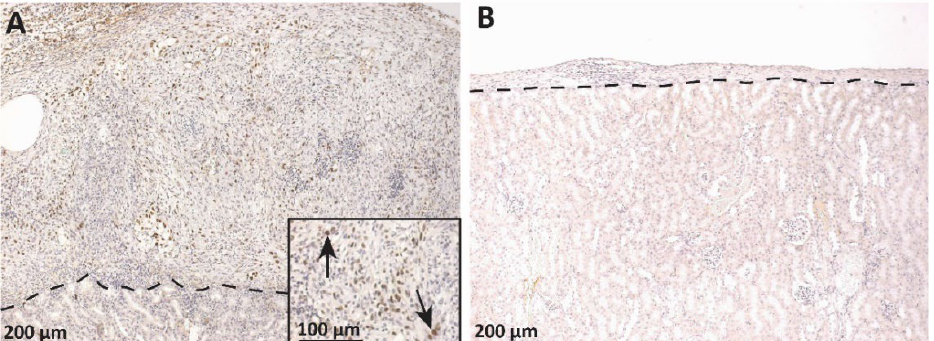
Figure 3. Immunohistochemical analysis of SC or MSC-1 cell allograft survival. Four million SCs or MSC-1 cells were transplanted under the kidney capsule of BALB/c mice. The grafts were collected on day 20 post transplantation and immunostained for SCs (WT1, brown ( A ) or MSC-1 cells, large T-antigen, brown ( B )). Inset in ( A ) is a higher magnification and is included for visualization of WT1 positive cells. A dotted line separates the graft (above the line) from the kidney (below line). Sections were counterstained with hematoxylin (blue). Arrows indicate examples of positively stained cells.